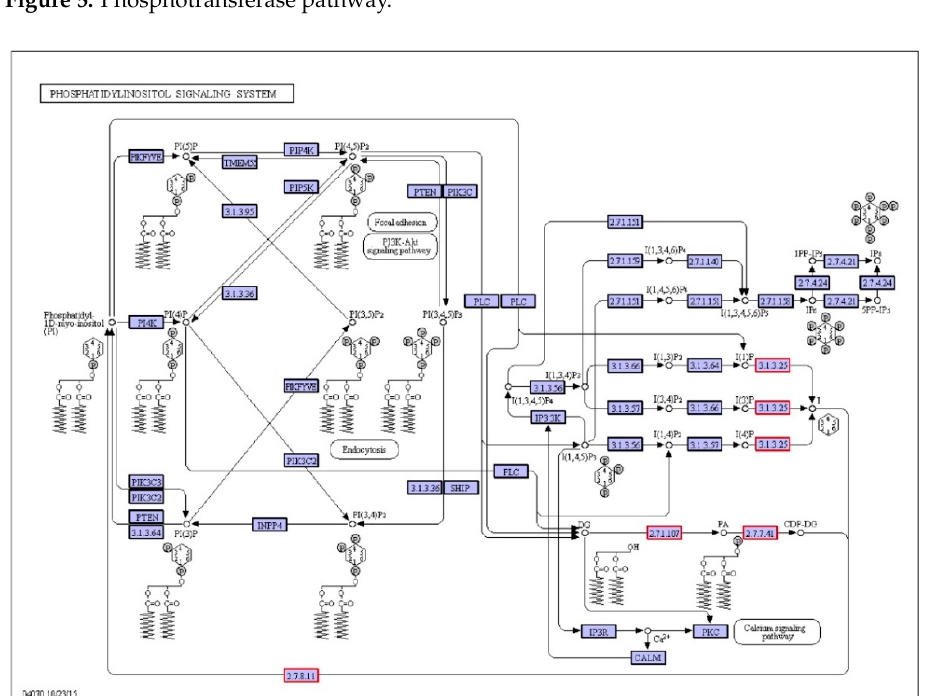
Figure 6. Phosphotransferase system pathway.